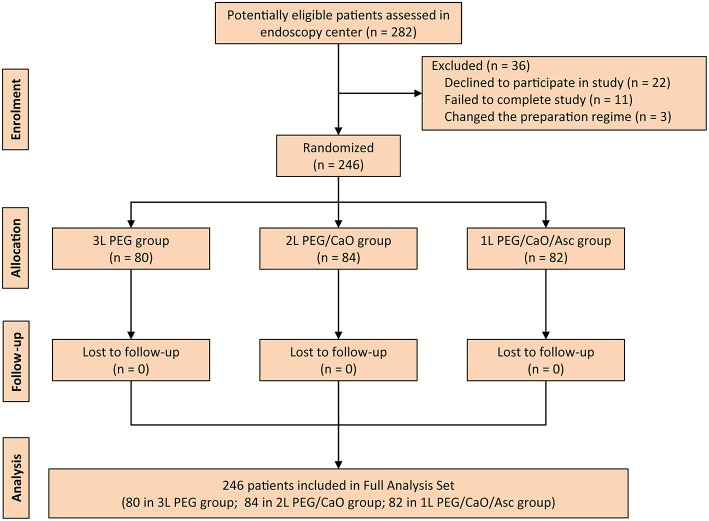
CONSORT diagram for the trial. PEG, polyethylene glycol; CaO, castor oil; Asc, ascorbic acid.